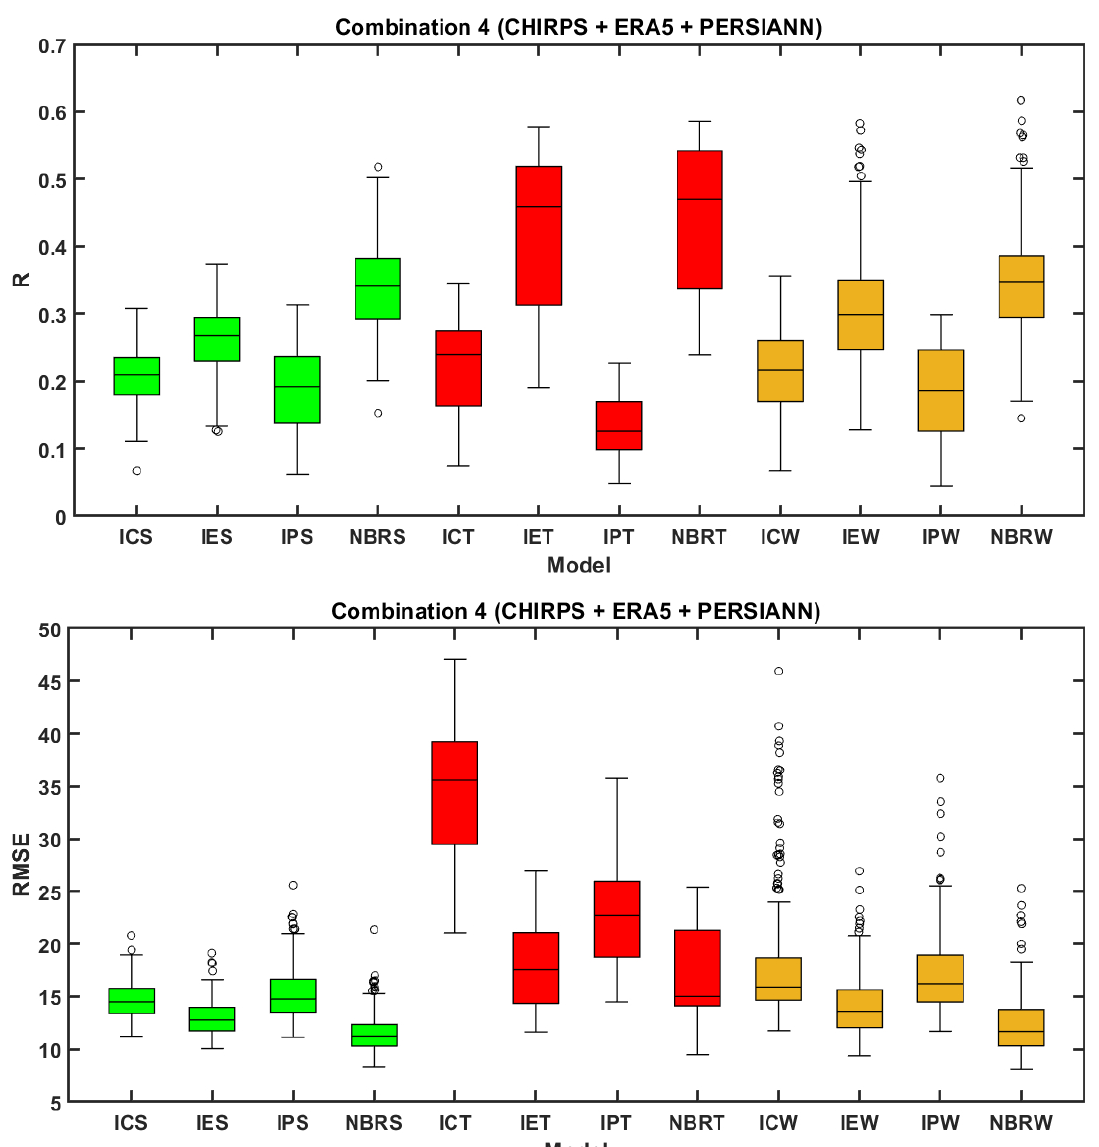
high error magnitudes (RMSE) when assessed at different temporal scales and climatic zones (Figure 8).